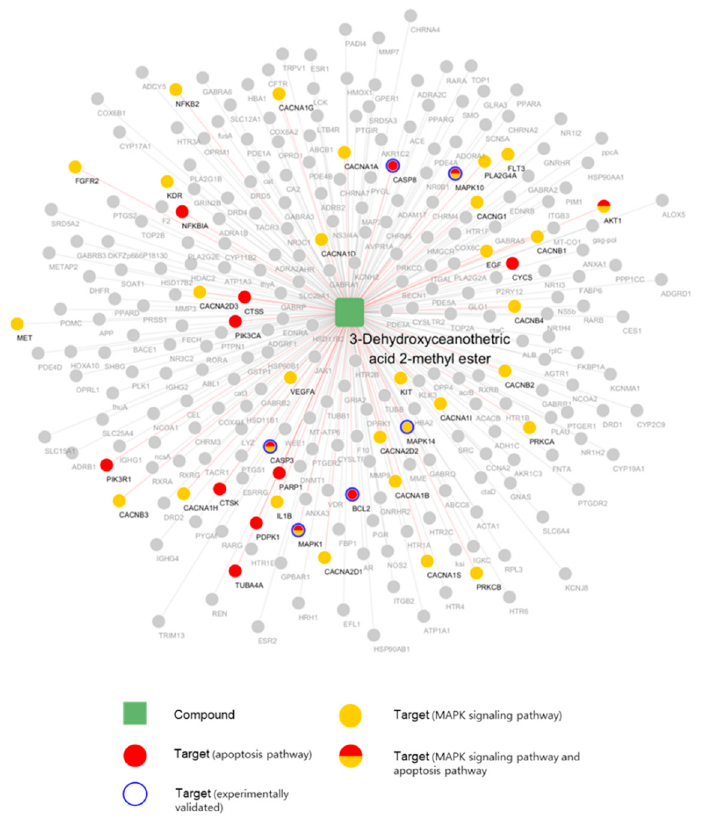
Figure 7. Compound-target network of 3DC2ME. Rectangles represent compounds, and circles represent the targets. Nodes related to MAPK signaling or apoptosis in the KEGG pathway are colored.